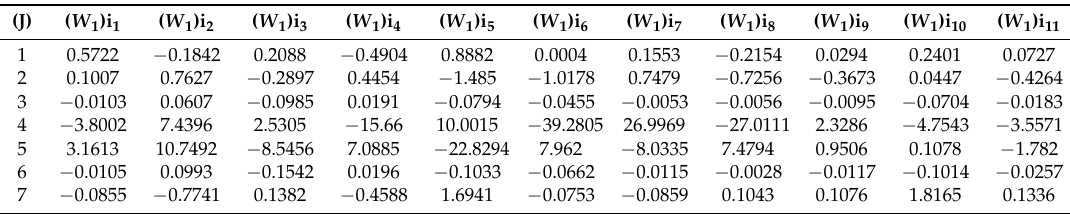
Table 3. Connection weight values for Equation (15).